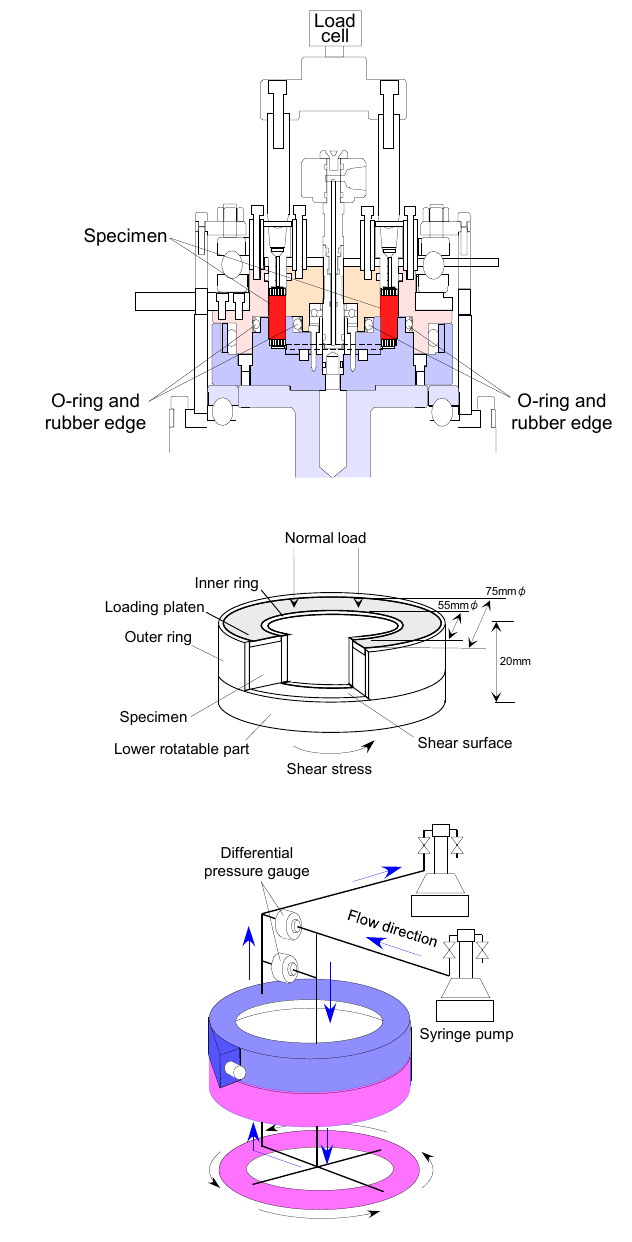
Figure 4. Schematics of the ring-shear apparatus, a specimen in the ring-shear apparatus, and the permeability measurement